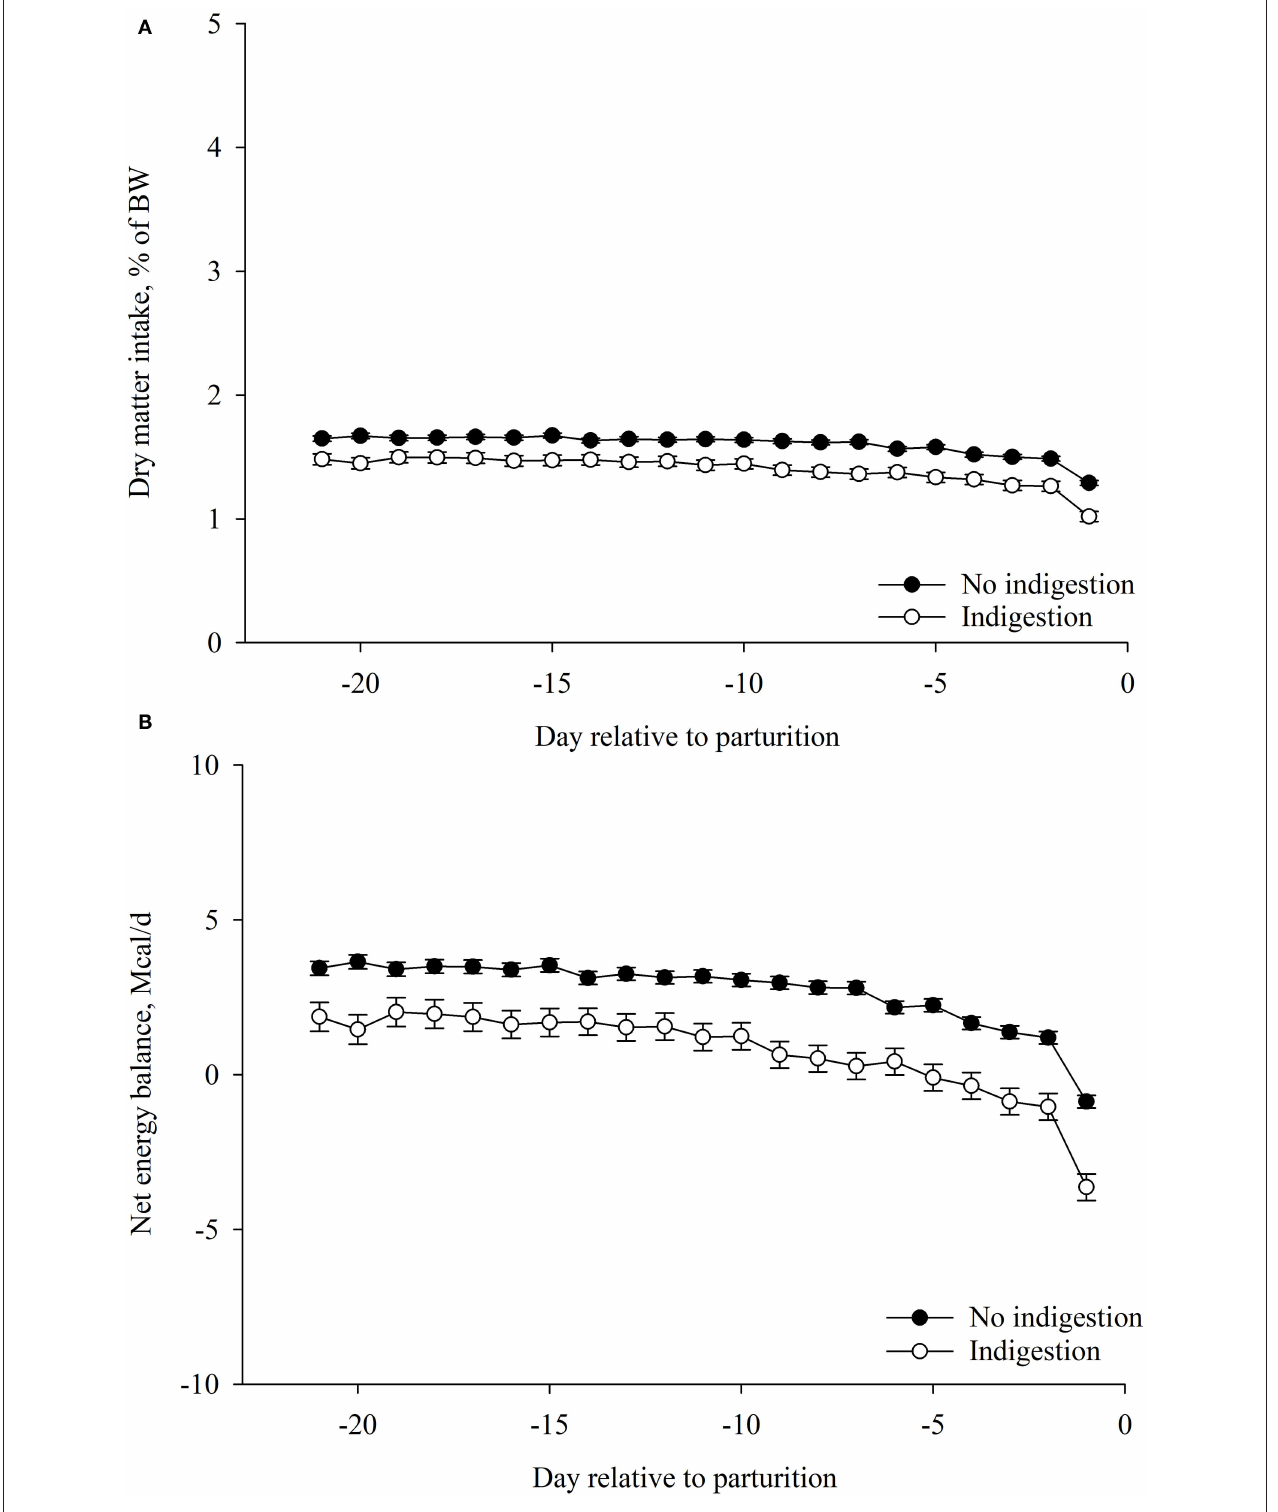
FIGURE 4 | Association of indigestion postpartum ( n = 118) with (A) dry matter intake (DMI, %BW) and (B) net energy balance (EB, Mcal/day) during the prepartum period (from − 21 to − 1 day relative to parturition). Values are least square means ± SEM. Prepartum DMI (%BW): indigestion, p < 0.01; day relative to parturition, p < 0.01; and the interaction between indigestion and day, p = 0.09. Prepartum net energy balance: indigestion, p < 0.01; day relative to parturition, p < 0.01; and the interaction between indigestion and day, p = 0.04. * p ≤ 0.05.